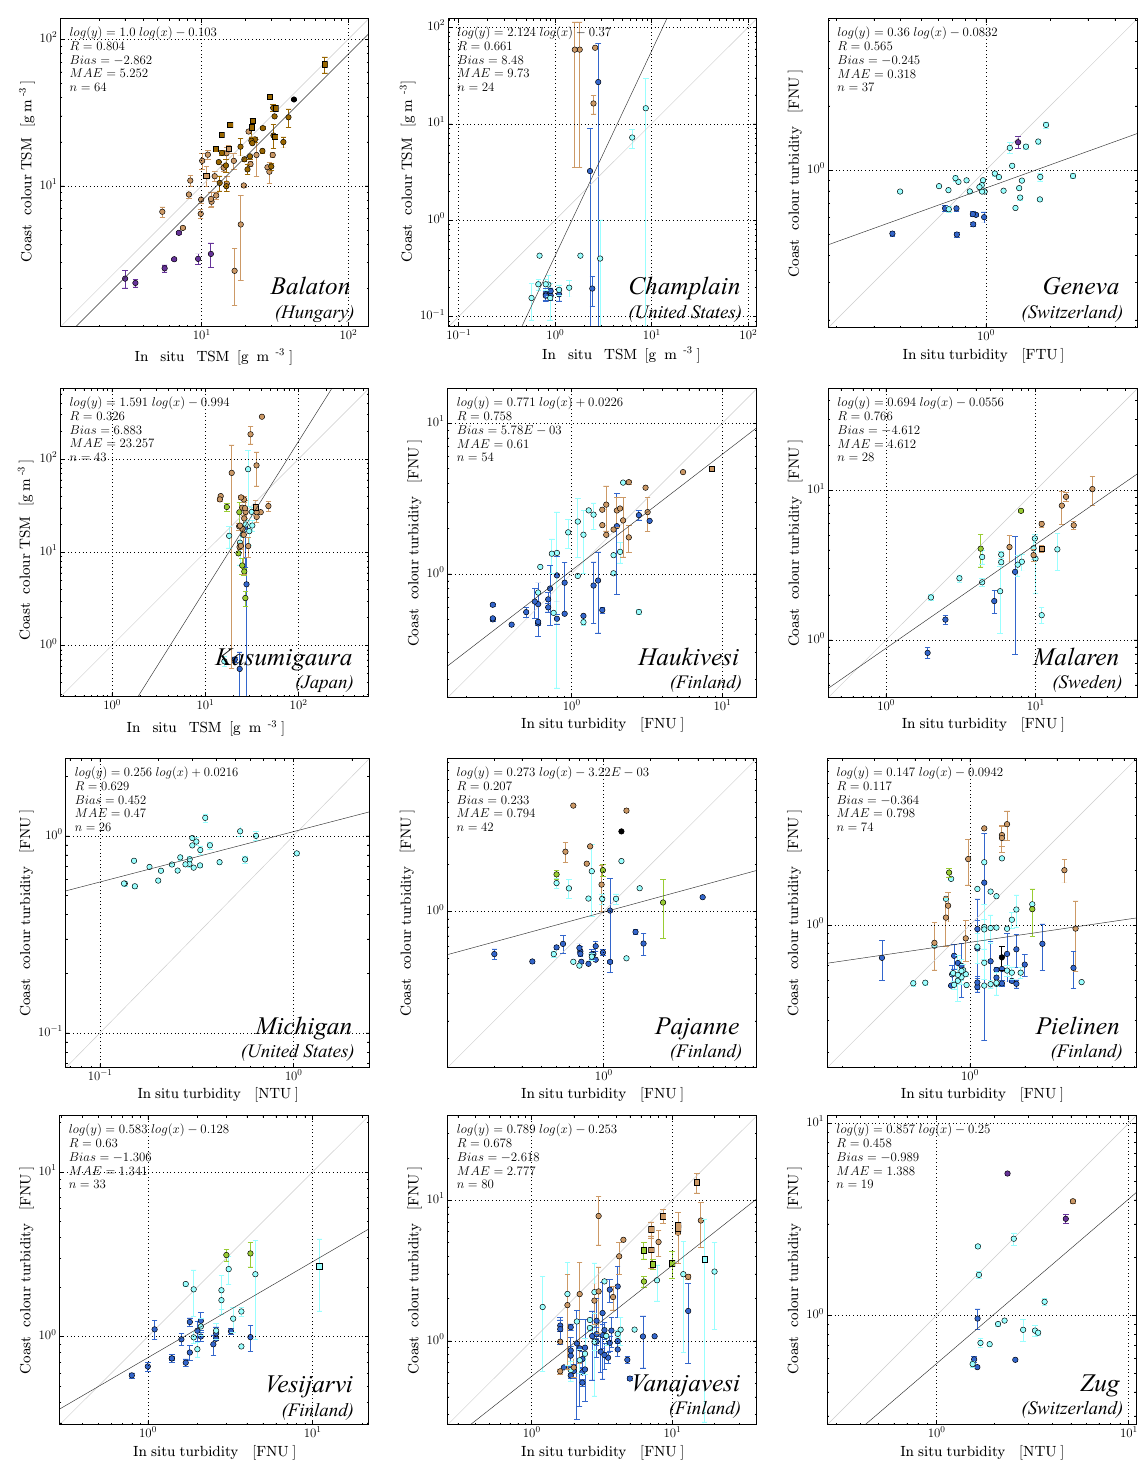
Figure 9. Matchup comparisons between remotely sensed TSM or turbidity, and monitoring measurements. Colours represent the dominant OWT in the nine matchup pixels according to Fig. 2 (black: OWT classification not possible), and error bars indicate their standard deviation.